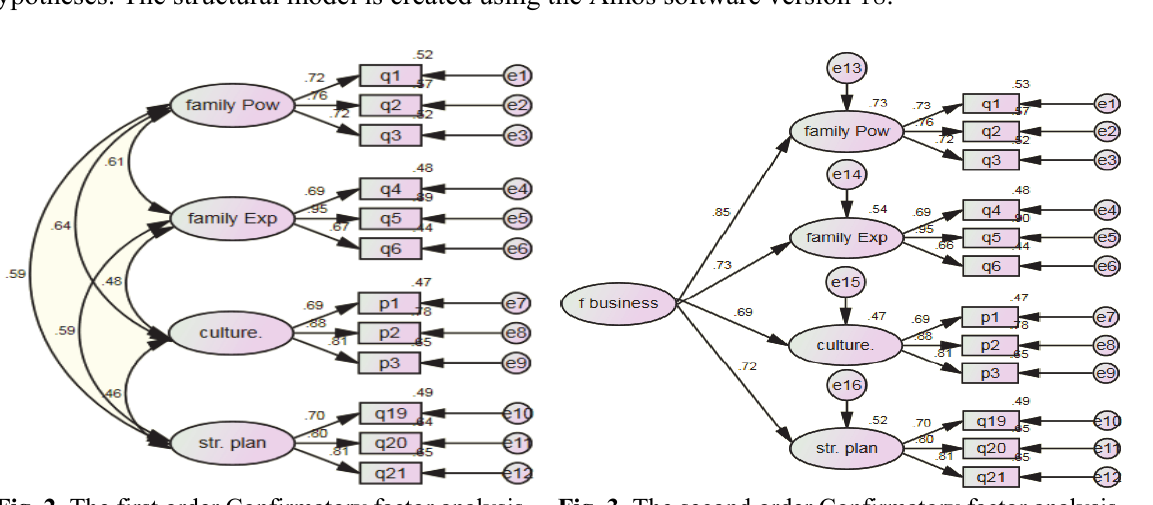
Fig. 2. The first order Confirmatory factor analysis Fig. 3. The second order Confirmatory factor